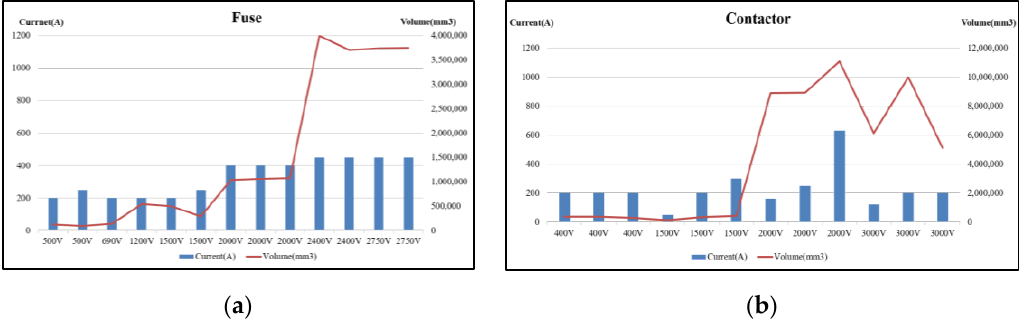
Figure 4. Comparisons of the battery pack components depending on voltage ratings: ( a ) fuse list; ( b ) contactor list.